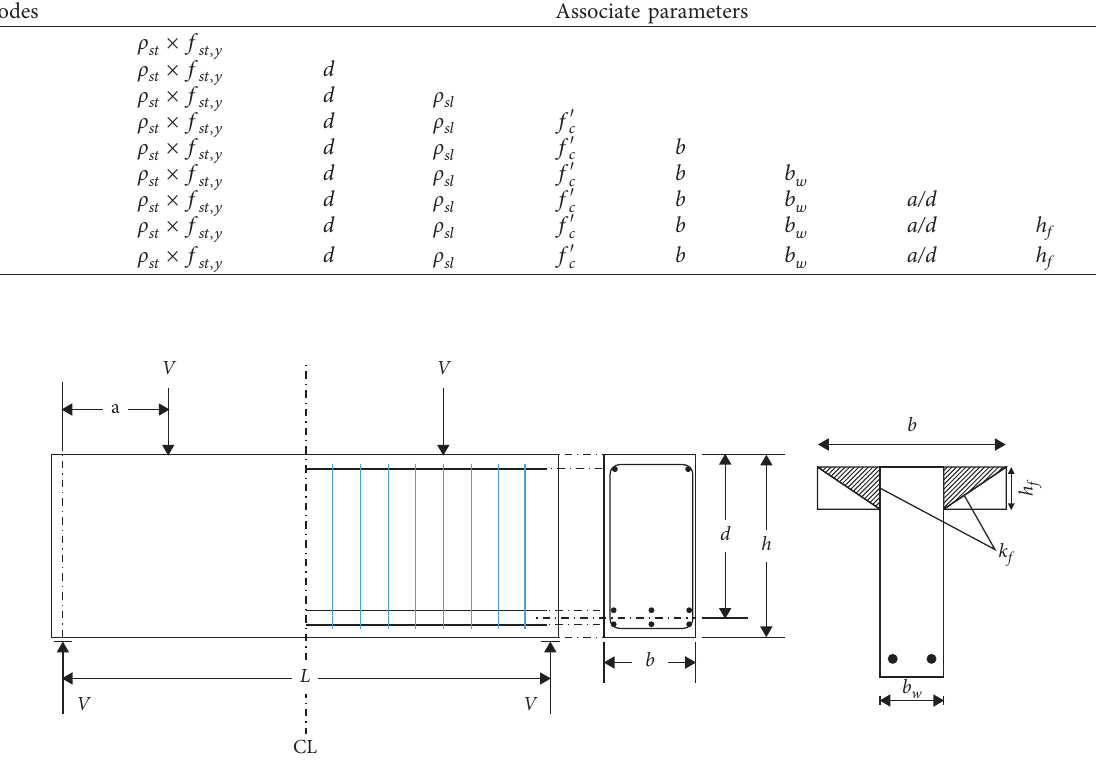
Figure 2: The studied reinforced concrete beam example experienced the shear strength case.